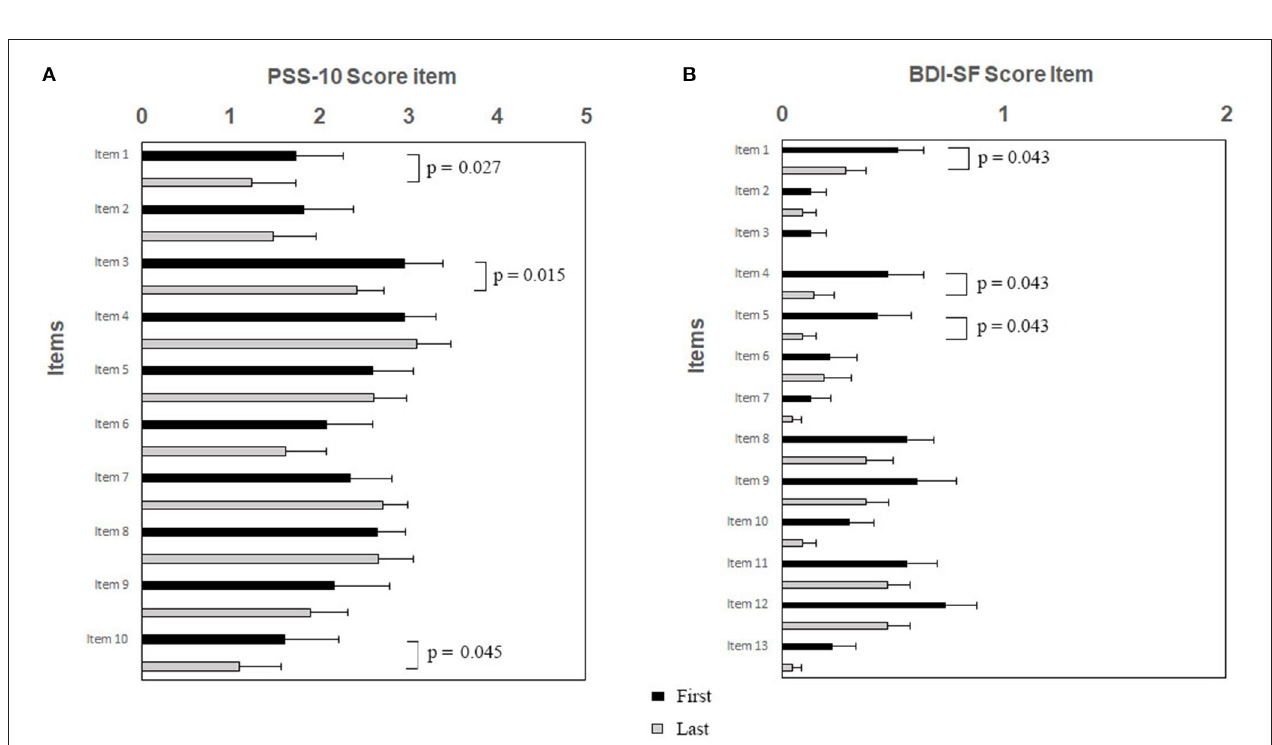
FIGURE 2 | (A,B) . RR training modulates specific items of PSS-10 (A) and BDI-SF (B) . Subjects were exposed to RR training and at the beginning of each session both questionnaires were administered. Histograms showing specific PSS-10 and BDI-SF items are presented as black/gray bars indicate first/last sessions, respectively. Note the significant decreases of scores between sessions after RR training specifically for PSS-10 items 1, 3, and 10, and for BDI-SF items 1, 4, and 5, respectively. Data are presented as mean values (Mean ± SEM) and comparisons between groups were made by Wilcoxon test with a significance of p ≤ 0.05.